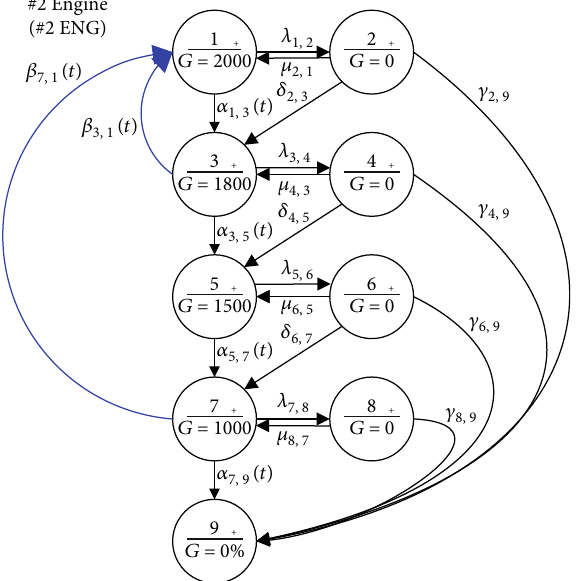
Figure 11: State-transition diagram of No. 2 engine.